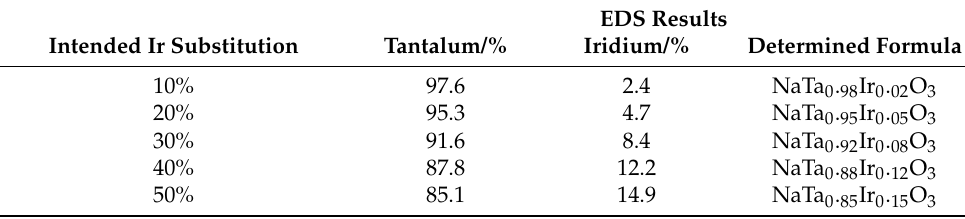
Table 2. EDXA of Ir-substituted NaTaO 3 materials performed using scanning electron